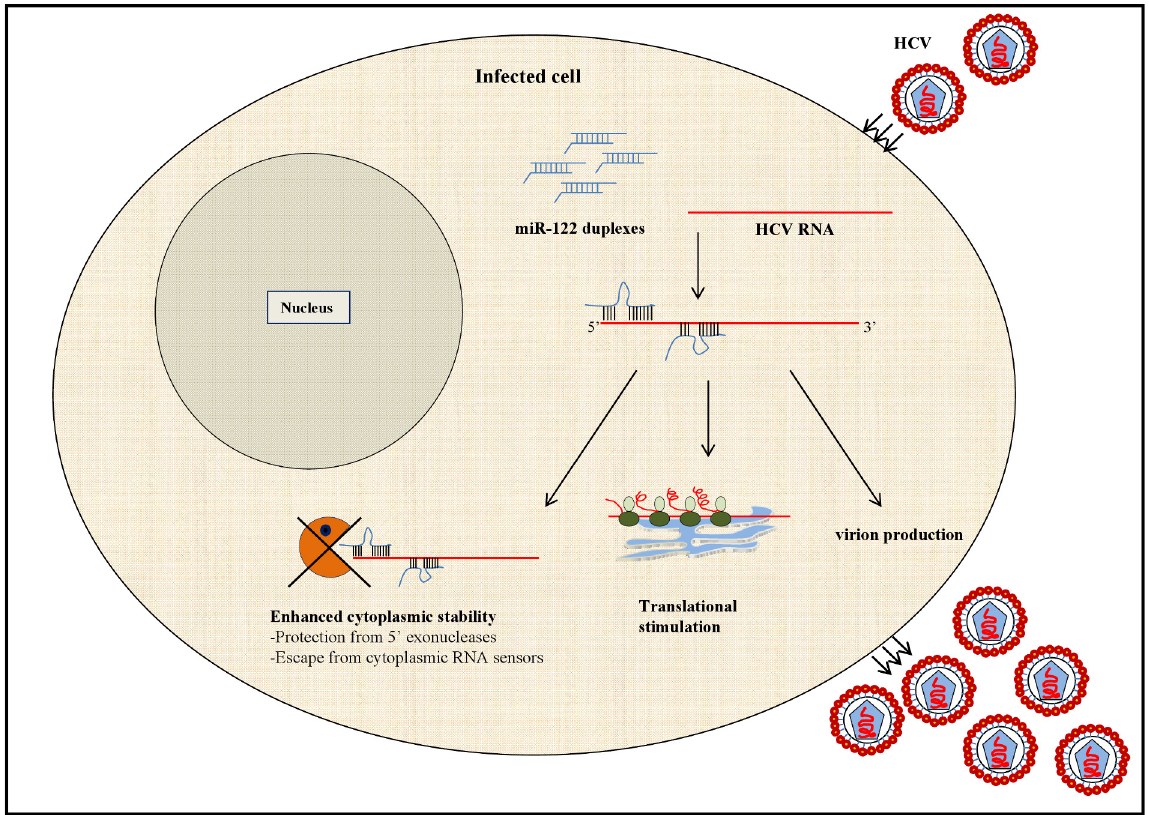
Figure 2. Mechanisms implicated in miR-122 mediated increase in HCV RNA abundance. MicroRNA (miRNA)-122 binds at two sites within the 5’UTR of the HCV RNA forming a unique miRNA-viral RNA complex characterized by 3’ overhang and internal bulge within the miRNA molecules. The 3’ overhang of miR-122 at the first site is proposed to mask the 5’ end of the HCV RNA and to increase its cytoplasmic stability by preventing its recognition by cytoplasmic RNA sensors such as the retinoic acid-inducible gene-I (RIG-I) as well as nucleolytic digestion by 5’ exonucleases. Additionally, binding of miR-122 to the HCV RNA stimulates virus release and viral RNA translation by enhancing the association of the 48S translation initiation